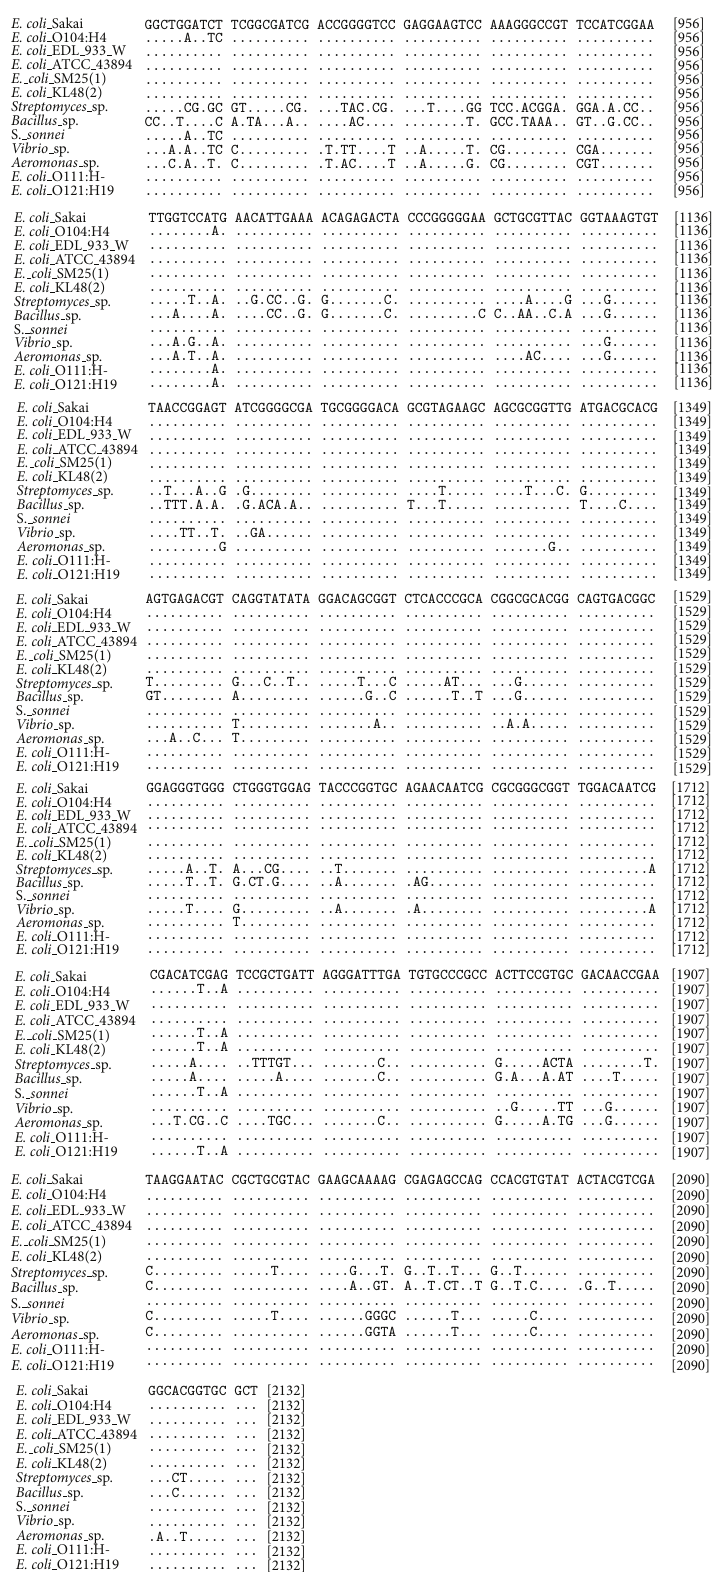
Figure 1: Nucleotides sequence of the 16S rRNA gene of the isolates E. coli SM-25(1) and E. coli KL-48(2) among nucleotides sequence of those available in databanks. Data indicated the position of nucleotides different among isolates and identical data for all isolates are not